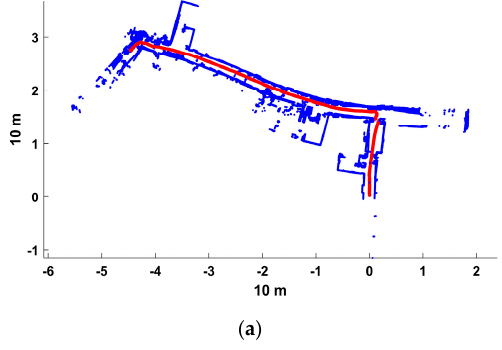
Table 3. Deviation in the translation and